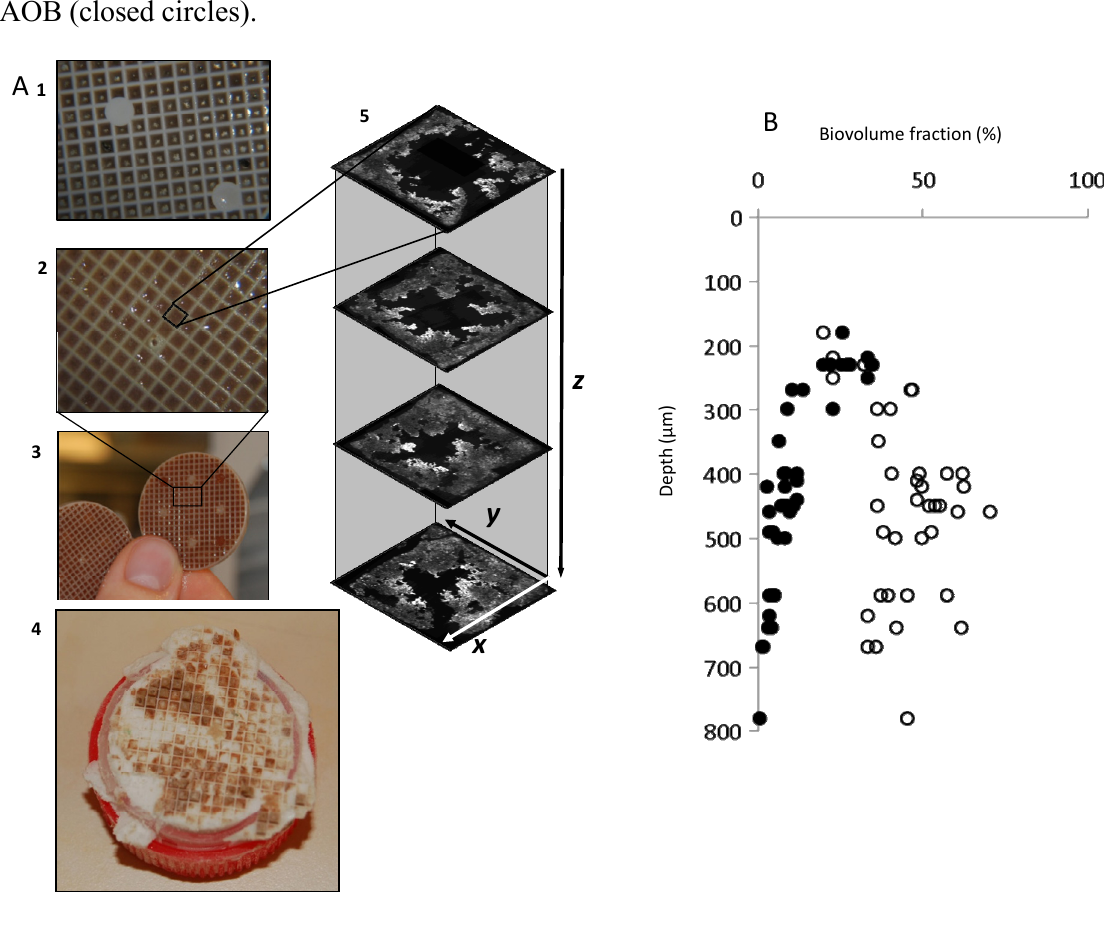
Figure 1. Overview of sample retrieval and analysis. Biofilm carriers containing either young ( A1 ) or mature biofilm ( A2 , 3 ) were cryo-embedded and frozen; After removal of the carrier, biofilm from carrier compartments was frozen solid and associated with the O.C.T. compound ( A4 ); Cryosectioning of the biofilm was followed by FISH and CLSM analysis of biofilm stratification in the x , y and z dimensions ( A5 ); and vertical ( z ) distribution from one of the compartments is exemplified in ( B ), anammox (open circles), AOB (closed